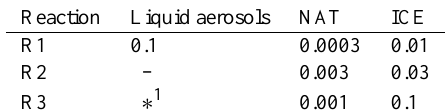
Reaction Liquid aerosols NAT